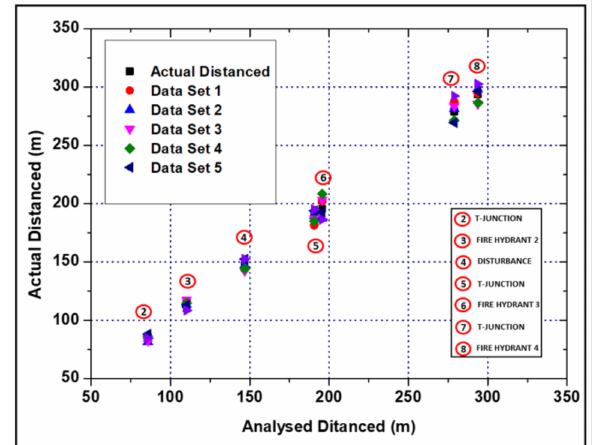
Figure 25. Scatter plot on repetition for no-leak pipeline system analysis.